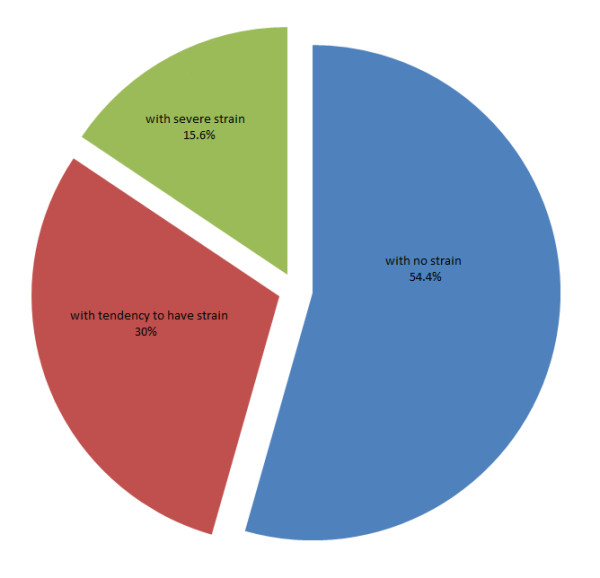
Caregivers' Strain.